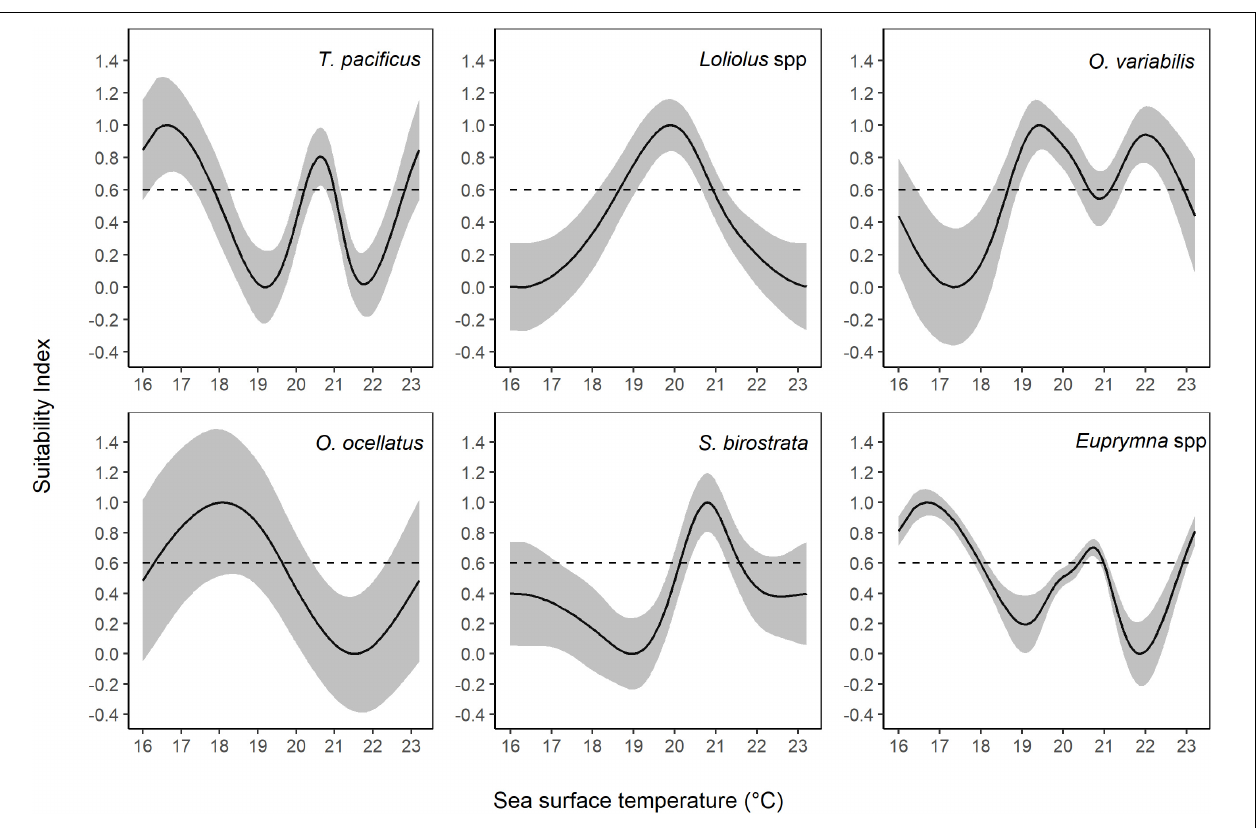
FIGURE 7 | Suitability index (SI) for sea surface temperature (SST) based on the smoothing spline regression method.